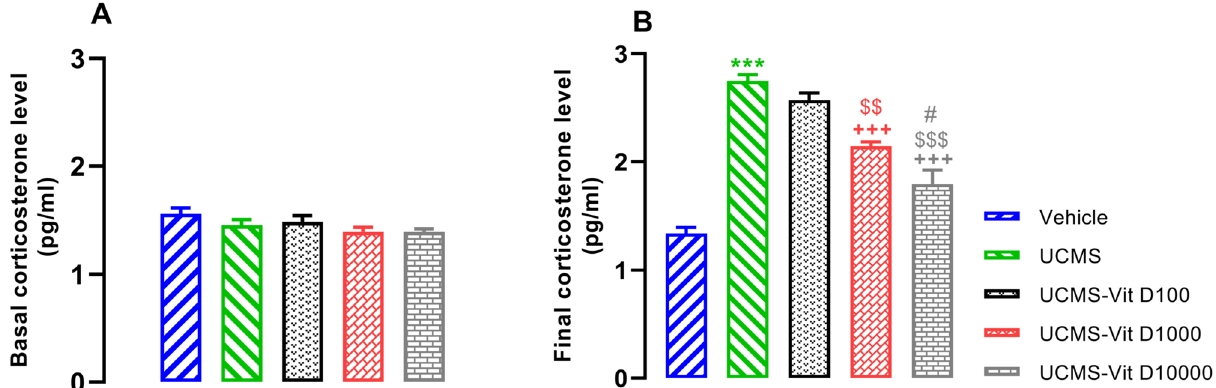
Figure 1. Serum corticosteone level in experimental groups. ( A ) Basal (pre-stress) and ( B ) final (post-stress) level of corticosteone. Data are presented as mean ± SEM, n = 10. *** P < 0.001 versus Vehicle group, + + + P < 0.01 versus UCMS group, $$ P < 0.01 and $$$ P < 0.001 versus UCMS-Vit D100 group and # P < 0.05 0 versus UCMS-Vit D1000